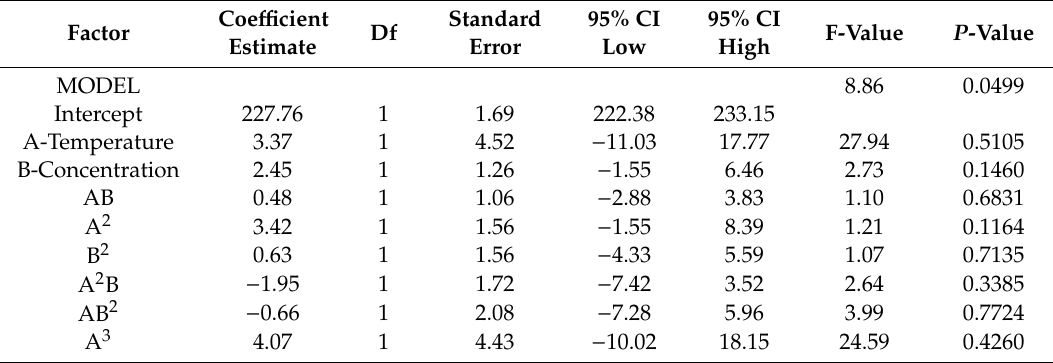
Table 9. Cubic model regression coe ffi cients statistical analysis.